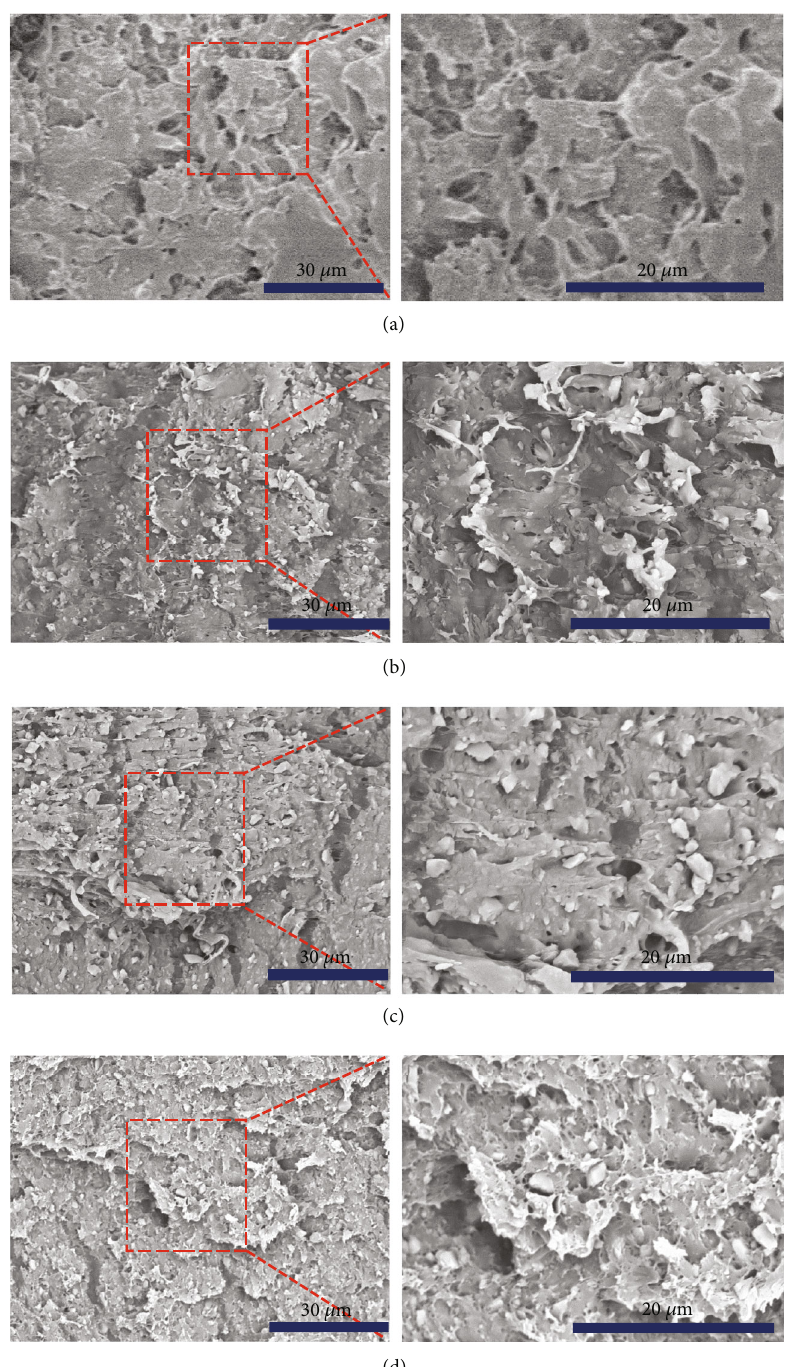
Figure 6: Composite morphology analysis by SEM images: (a) pure PLA, (b) PLA/abutilon straw (99/1), (c) PLA/abutilon straw (97/3), and (d) PLA/abutilon straw (95/5) biocomposites with a length scale of 20 μ m and 30 μ